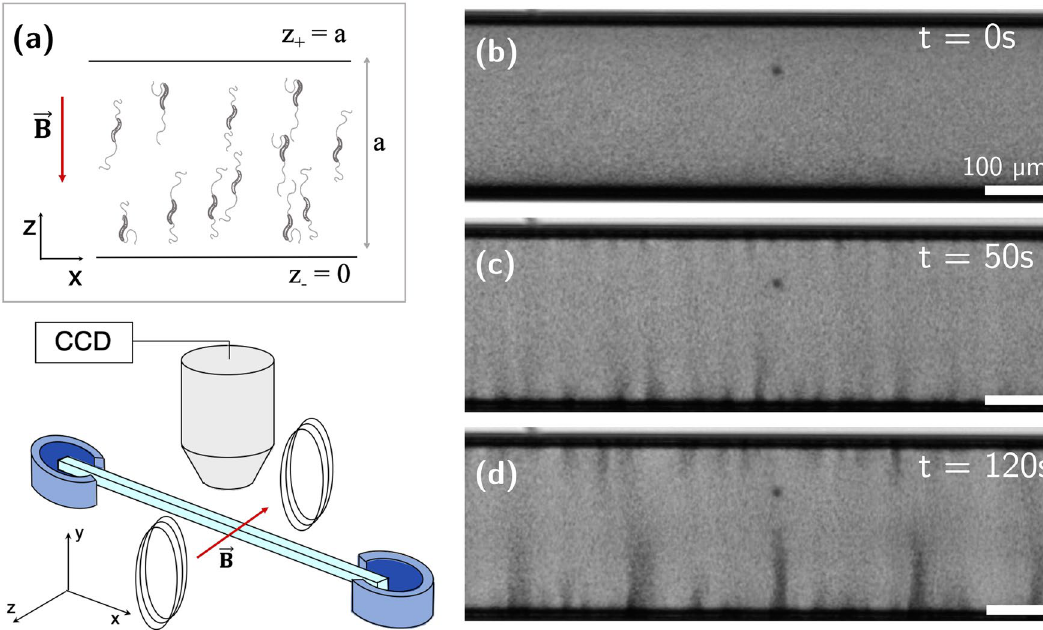
Figure 1. ( a ) Experimental set up and schematic view of the observed bacteria in the microscope under the magnetic field B . A glass capillary with square cross-section and pore size ranging from 80 µ m to 500 µ m , is held and sealed at both ends by two reservoirs filled with mineral oil. Two Helmholtz coils generate a uniform magnetic field and a microscope is used to image the bacteria. ( b ) Uniform distribution of bacteria in a capillary with dimensions 300 µ m square at t < 0 . The magnetic field magnetic field is then turned on at t = 0 . ( c ) At t = 50 s , bacteria accumulate near the z − wall, and the concentration instability emerges. ( d ) At longer times, plumes grow and cluster until a steady flow is obtained at t = 2 min